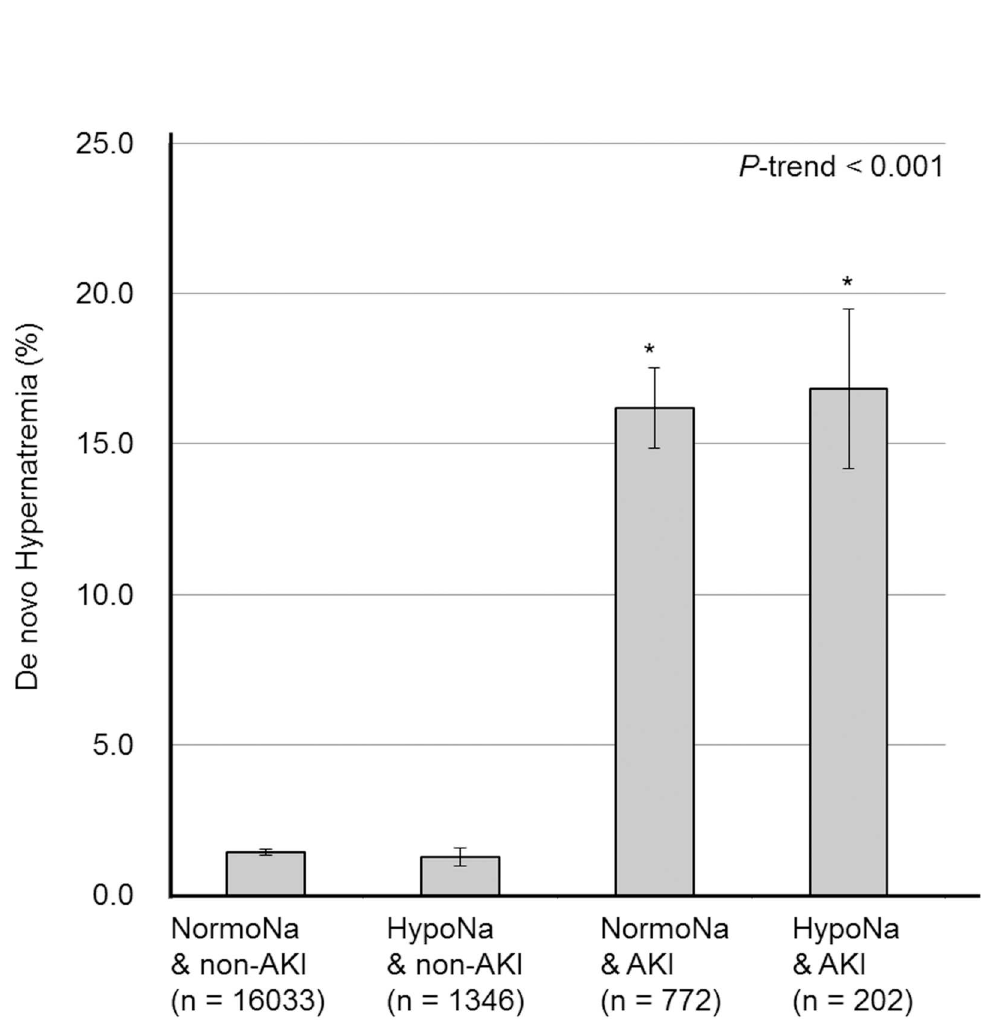
Fig 4. Proportionof de novo hypernatremia depending on the statusof combined sodium(Na)and acute kidney injury(AKI)group. Errorbar indicatesstandarderror. * indicates P < 0.05 by chi-square test when comparedto the normoNa&